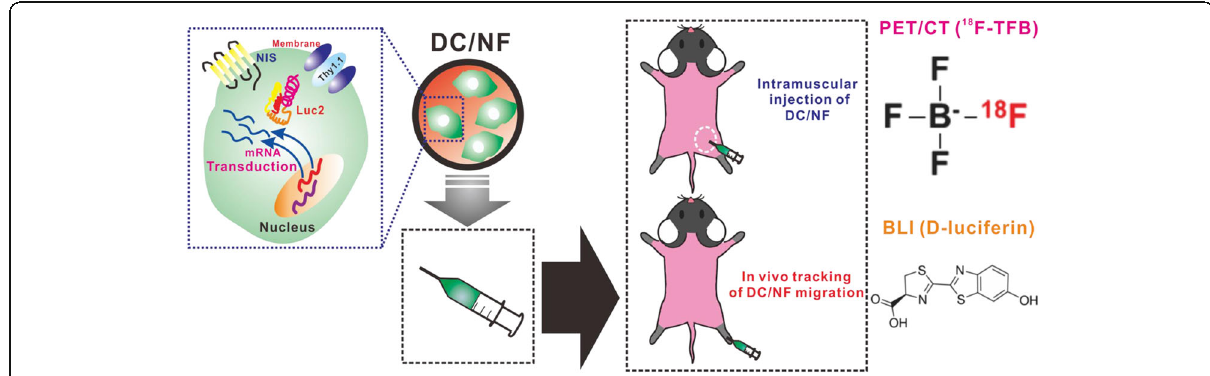
Fig. 1 Schematic representation of the in vivo tracking of DC migration by performing multimodal reporter gene imaging. The multimodal reporter system involves the NIS, Luc2, and Thy1.1 genes, which act as nuclear reporter, optical reporter, and surrogate for the NIS and Luc2 genes, respectively. The multimodal reporter genes were introduced into DCs retrovirally, and the reporter-tagged DCs were injected into the muscles and footpads of mice. Next, combined PET/CT imaging ( 18 F-TFB) and BLI ( D -luciferin) was